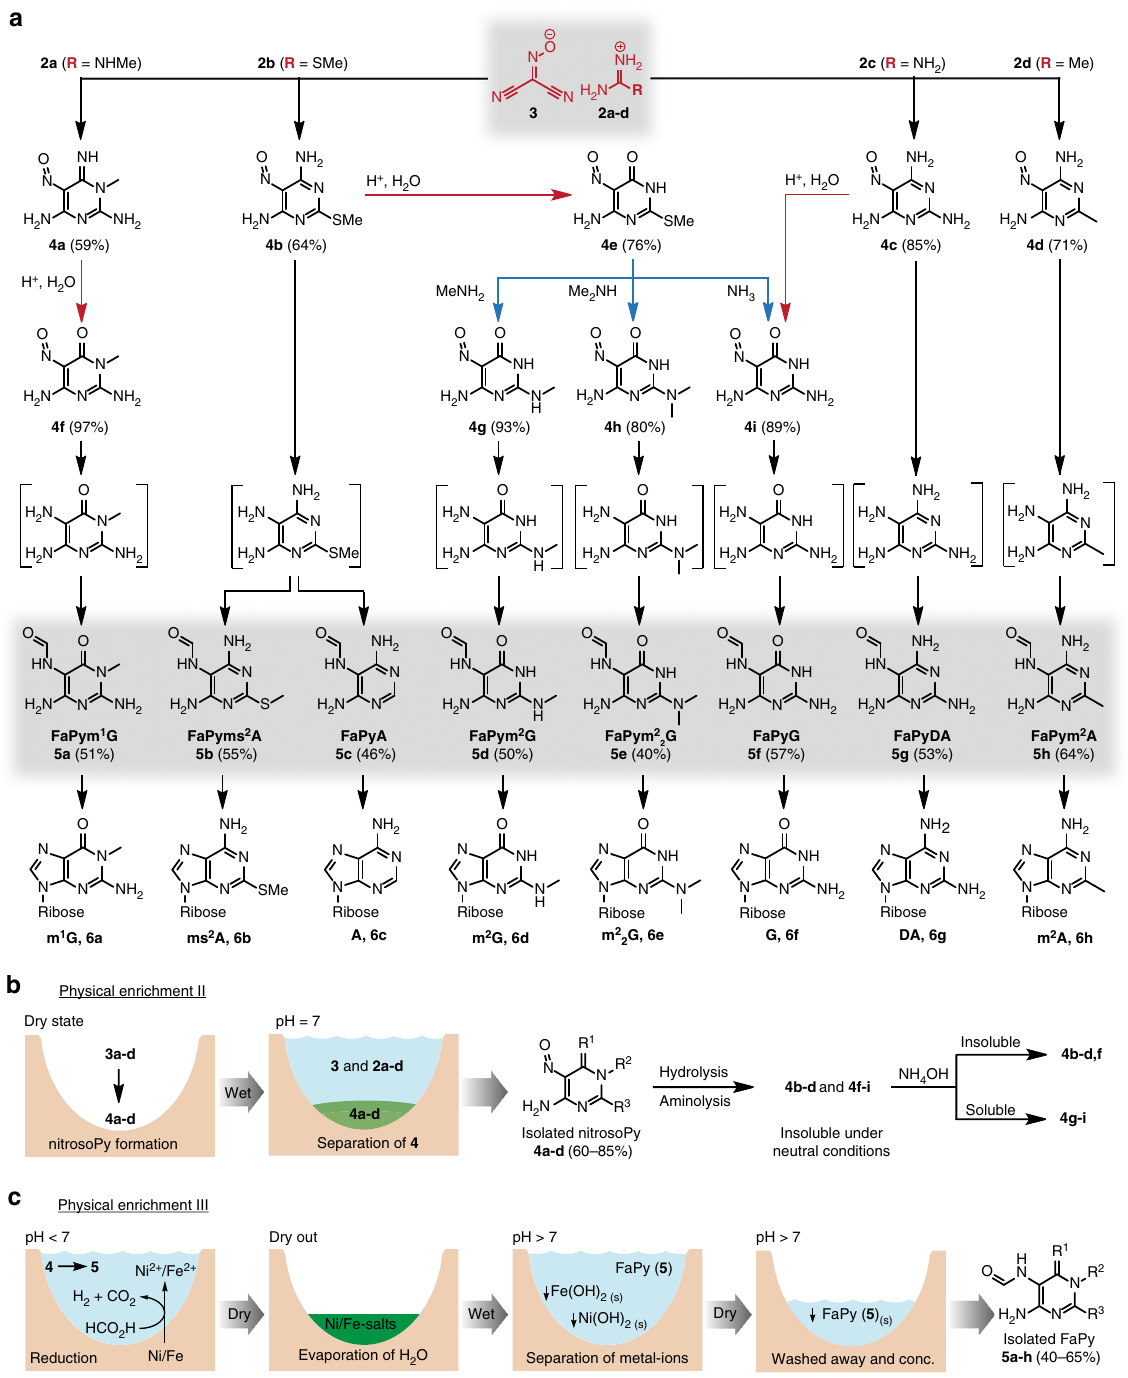
Fig. 3 Reaction scheme and physical enrichment of intermediates. a Dry-state reactions of salts containing 2a-d and 3 provide nitroso-pyrimidines 4a-d , which can be further diversi fi ed by hydrolysis (red arrows) or aminolysis (blue arrows) to give a set of nitroso-pyrimidines (nitrosoPys) 4a-i . In the presence of elementary Fe and Ni and dilute formic acid, formation of the formamidopyrimidines (FaPys) 5a-h as direct purine base precursors takes place. In square brackets: non-isolated reaction intermediates. b Second physical enrichment of the nitroso-pyrimidines isolated in high purity and yield. c Third physical enrichment of the formed FaPys 5a-h as nucleoside precursors from